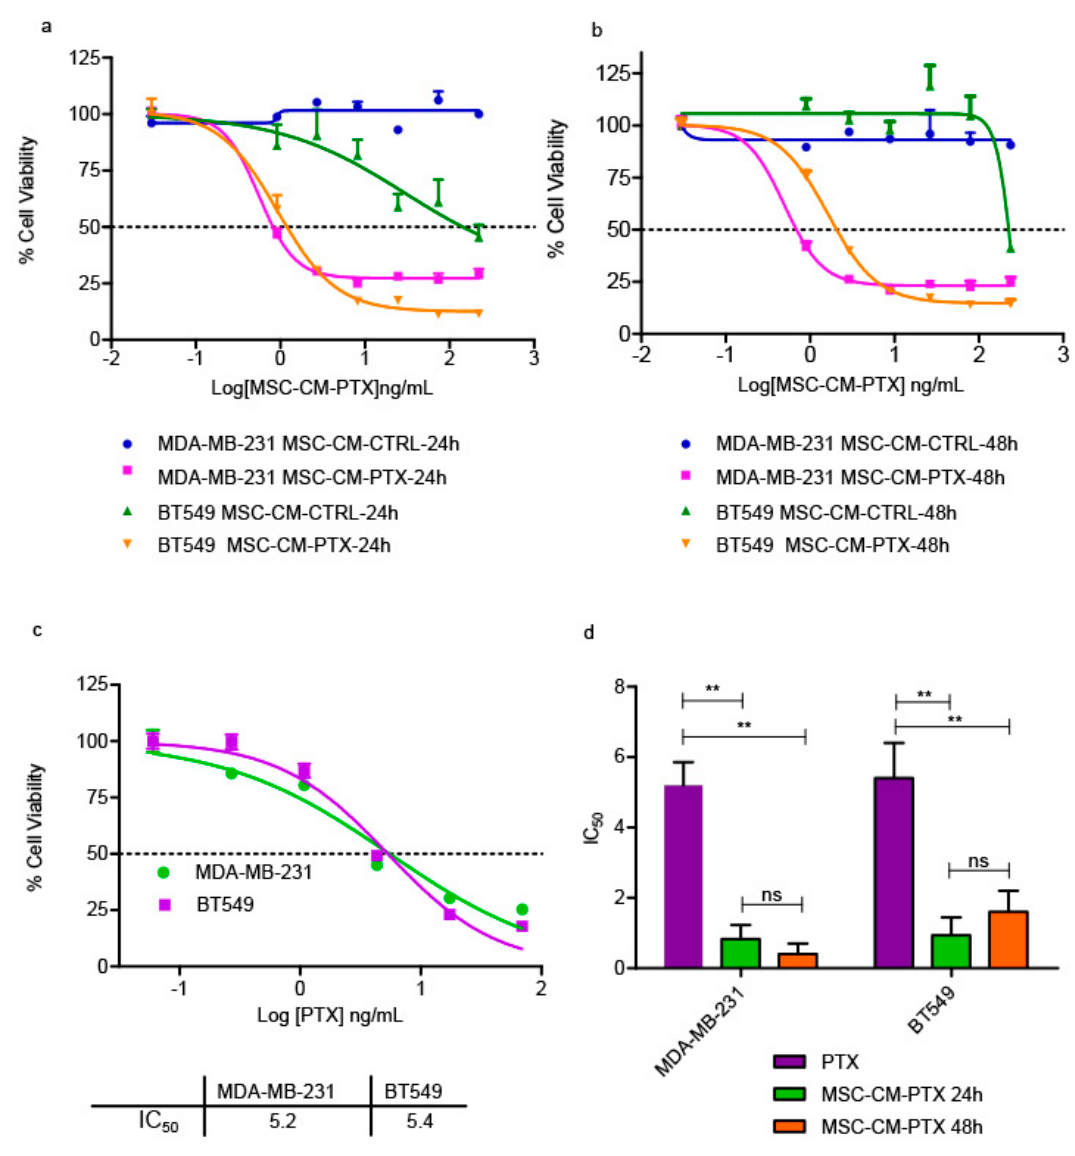
Figure 2. Viability inhibition in TNBC cell lines treated with MSC-CM at 72 h. Dose–response curves in MDA-MB-231 and BT549 cells showing the effects of treatment with different concentrations of MSC-CM PTX 24 h ( a ), 48 h ( b ) and free PTX ( c ). Dashed lines depict IC50 values. Both cell lines were examined in two independent experiments. Points, mean of duplicate (CM treatments) and triplicate (free PTX treatments) determinations, and error bars described SEs. The histogram reports the mean IC50 values ± the standard deviations (SDs) for both cell lines treated with MSC-CM PTX 24 h and 48 h in duplicate ( d ). Unpaired t -tests determined the p -values: ** p <